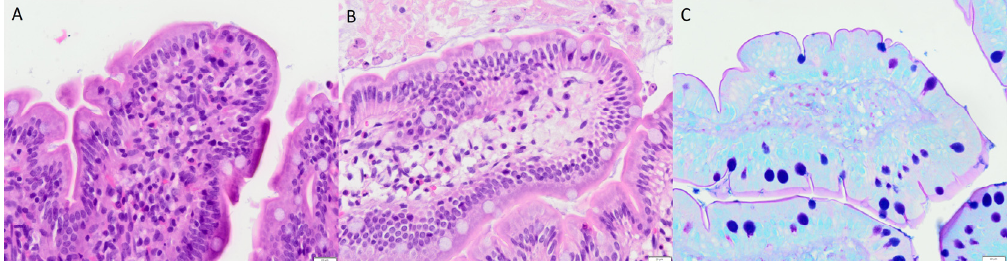
Figure 4. Two pictures ( A , B ) of hematoxylin and eosin-stained villous tips, and one ( C ) picture showing Alcian blue–PAS (pH 2.5)-stained mucus (original magnification ×400). ( A ) The villous tip contain a moderate, densely packed infiltrate of macrophages, lymphocytes, plasma cells, and eosinophils. No neutrophils were present. ( B ) An edema is shown with an increase of the intercellular stroma and a loose presence of inflammatory cells and fibrocytes. Lymphatic and blood vessels are dilated. The epithelium is intact. ( C ) A continuous small layer of magenta-positive mucus at the luminal apical face of the enterocytes. The goblet cells display a blue-purple mucus. Apoptotic cells and macrophages containing small mucus droplets are seen under the epithelium. Experimental groups: ( A ) melatonin 100 mM, ( B ) misoprostol 10 mM, and ( c ) control.